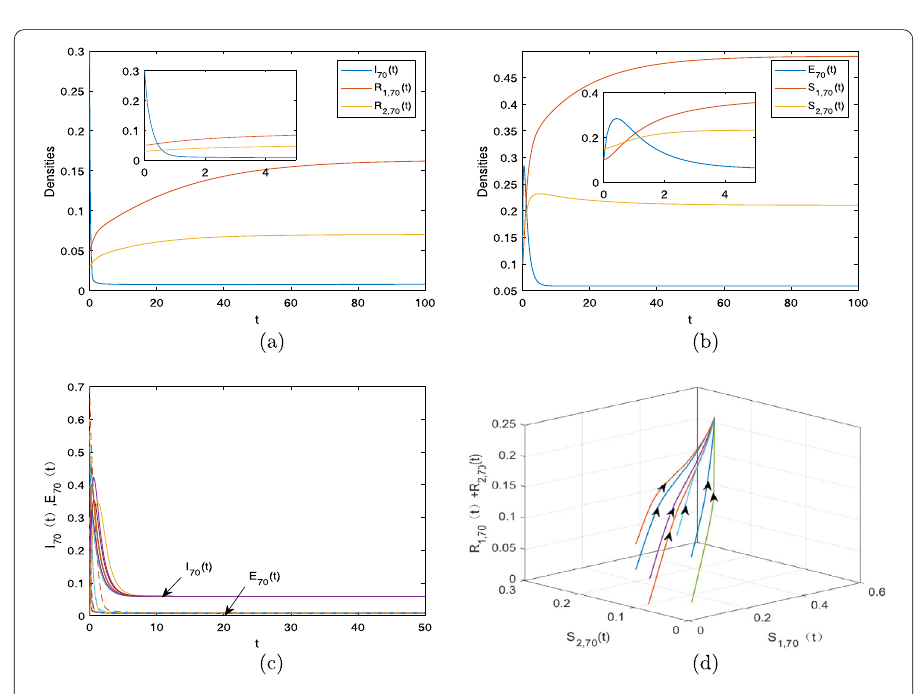
Figure 5 The stability of (cid:18) E ∗ in model (1) with R 0 > 1